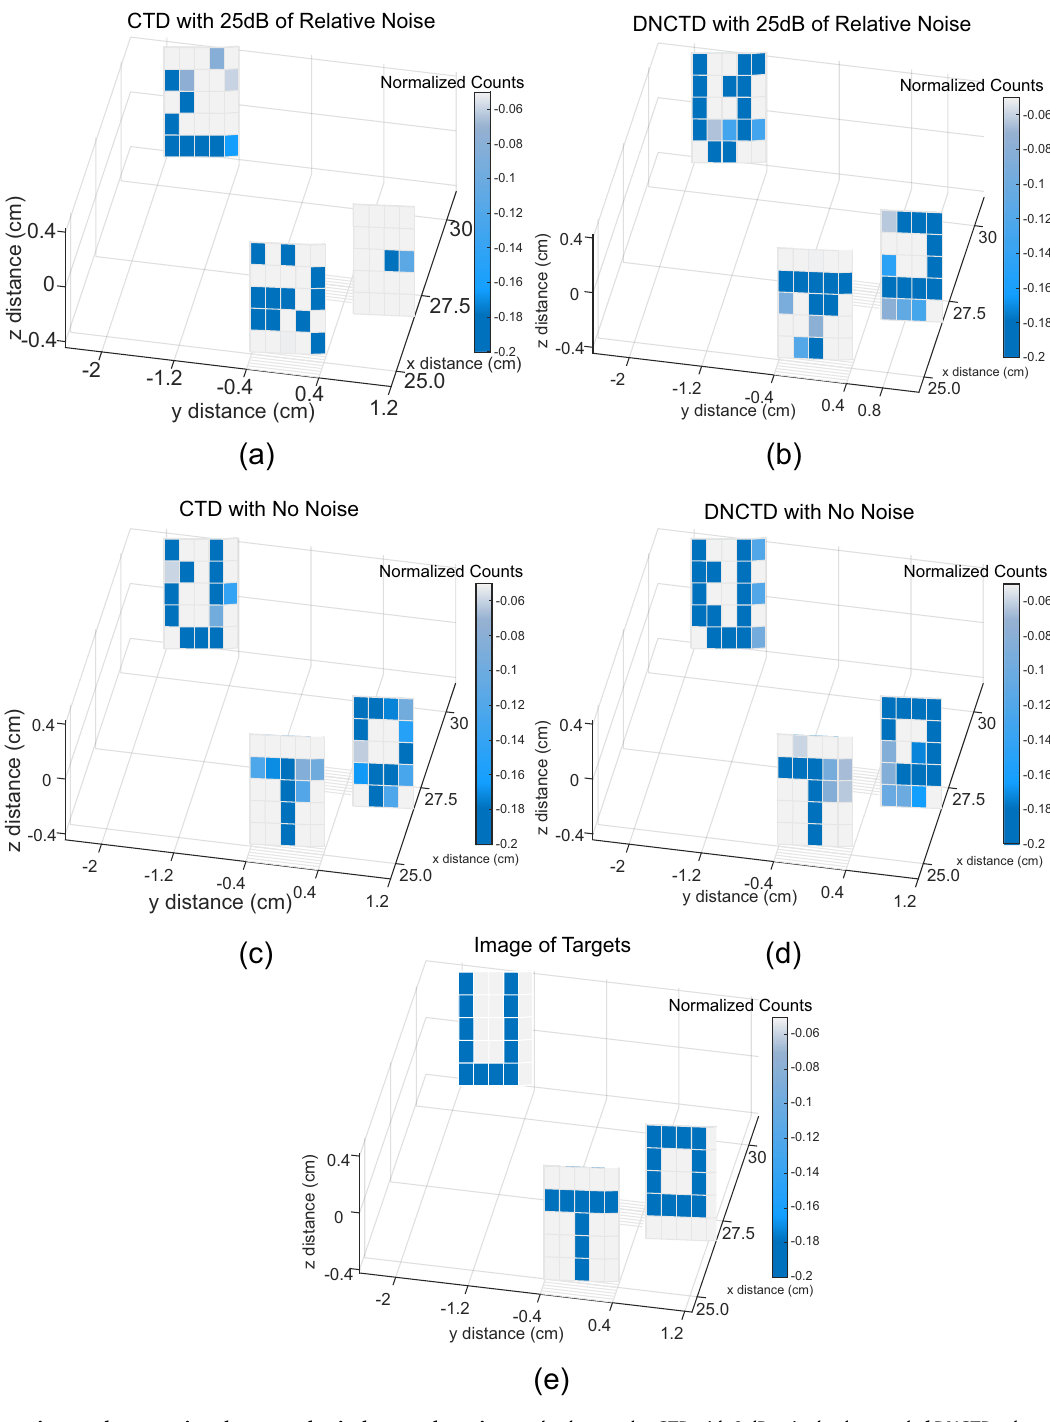
background, c CTDwith0dBnoisebackground, d DNCTDschemewith0dBnoise background, e A numerical simulation of ideal imaging of all three